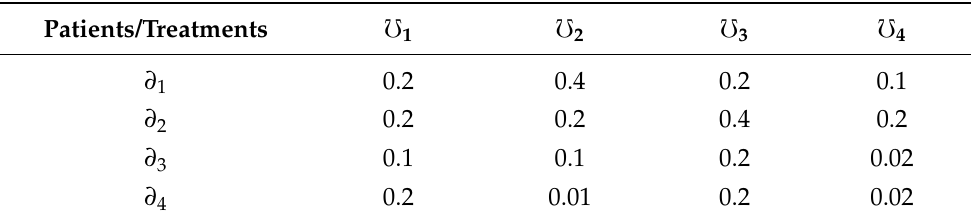
Table 16. W 3 tabular representation: After the third therapy event, the patient’s improvement report. C Patients/Treatments